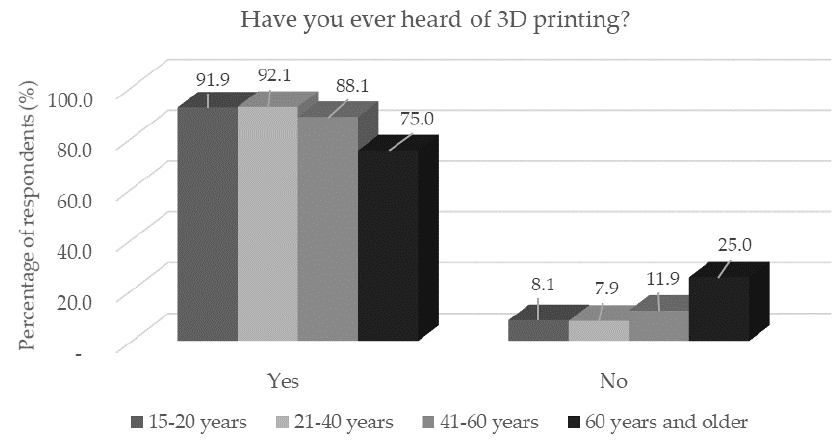
Figure 1. Respondents’ awareness of 3D printing ( n = 1156) by age category in response to the question: "Have you ever heard of 3D printing?”. Table 2. Three-Dimensional Common Printing Awareness, 3D Food Printing Awareness. Distribution of respondents